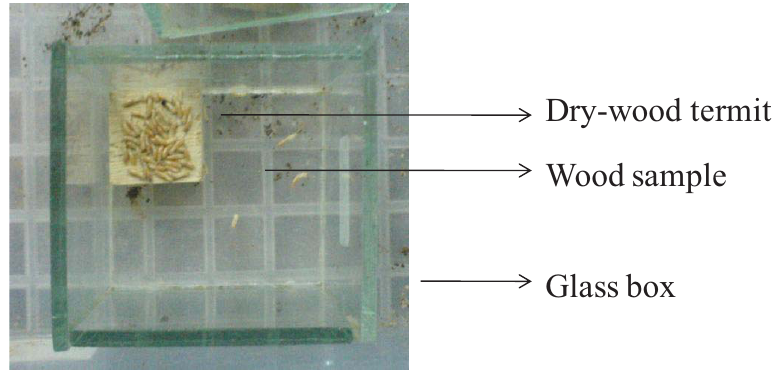
Figure 1. Glass box of dry-wood termite test [3].